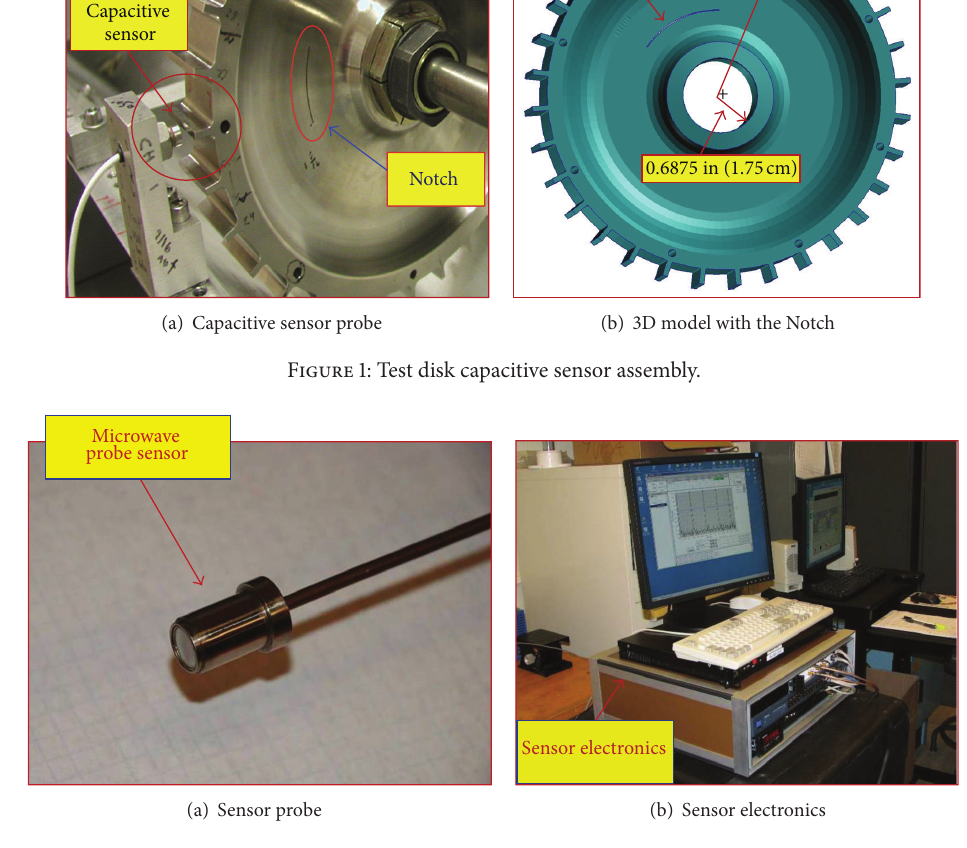
Figure 2: Microwave sensor probe and its electronics